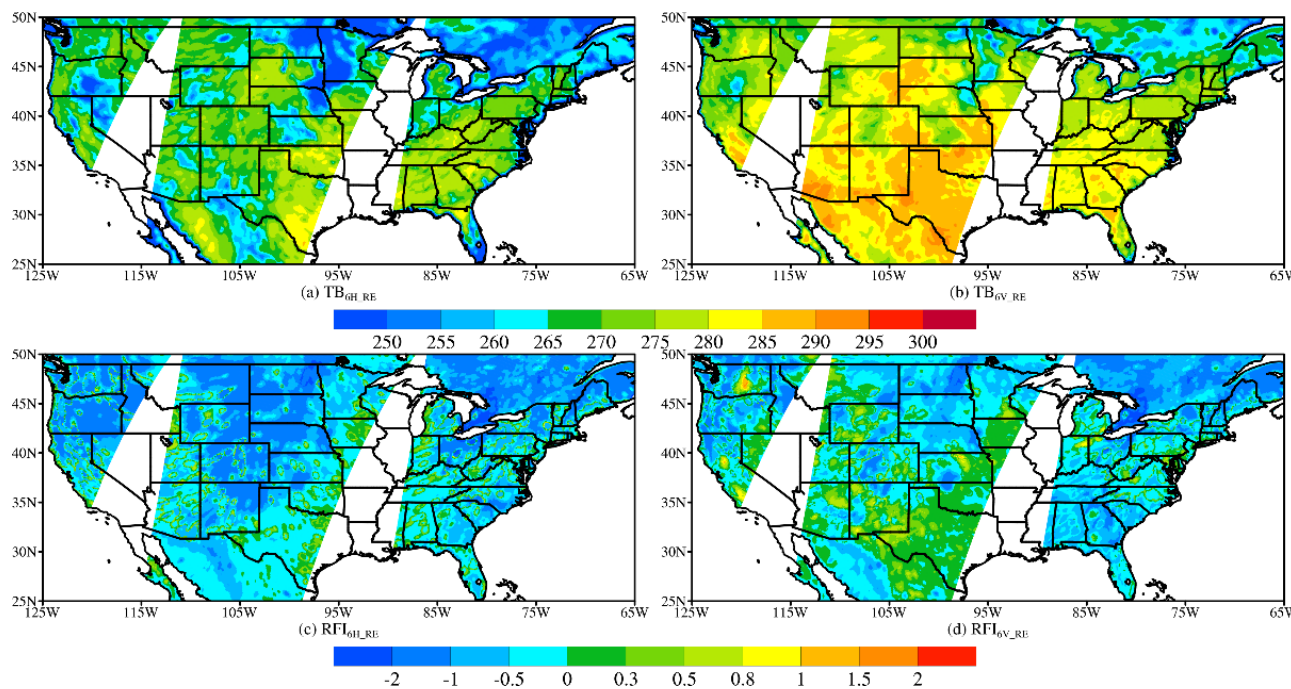
Figure 3. Spatial distribution of the brightness temperature ( a , b ) and RFI ( c , d ) after restoration under 6 GHz horizontal polarization ( a , c ) and vertical polarization ( b , d ) on 18 June 2016.